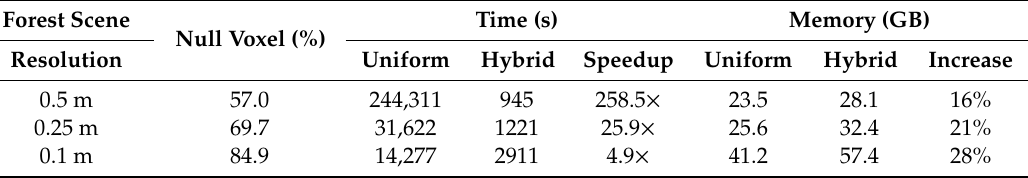
Table 2. Computational resources used by simulating the RAMI forest scene. Forest